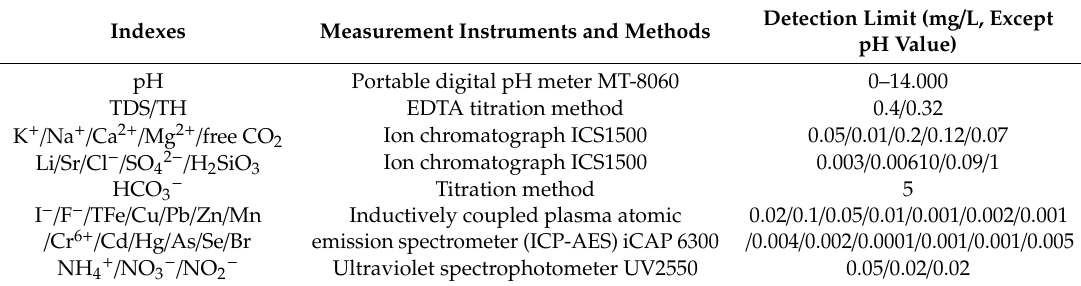
Figure 1. The distribution of sampling points of LLV and CA. Table 2. Analytical measurement instruments, methods and detection limit of indexes.